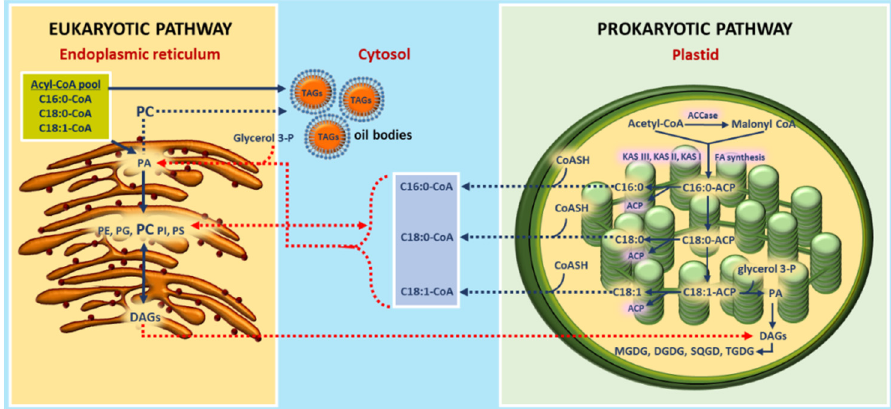
Figure 1. General overview of lipid biosynthesis in plants. Membrane lipid biosynthesis occurs via the eukaryotic (left panel) or prokaryotic pathway (right panel) in the endoplasmic reticulum and plastid, respectively. In both pathways, the synthesis of phosphatidic acid (PA) initiates the first step in lipid synthesis. Fatty acid synthesis occurs in the plastid through a series of reaction that incorporates acyl moieties of acetyl-Coenzyme A (-CoA) into acyl group of 16 or 18 carbon atoms. Fatty acids from acyl-acyl carrier protein (ACP) or acyl-CoA are transferred to a glycerol-3-phosphate (glycerol 3-P) to synthesize PAs. The PAs are converted to diacylglycerols (DAGs) which then serve as precursors